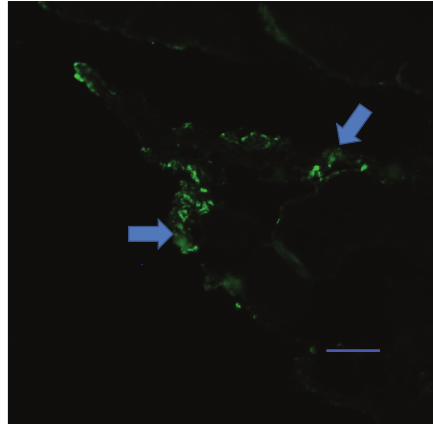
Figure 5: Antibody staining of neuromuscular junctions in the experimental group. The junction of nerve (upper left corner) and muscle (right hand side) was positive (arrow) for synaptophysin staining. Scale bar: 400 𝜇